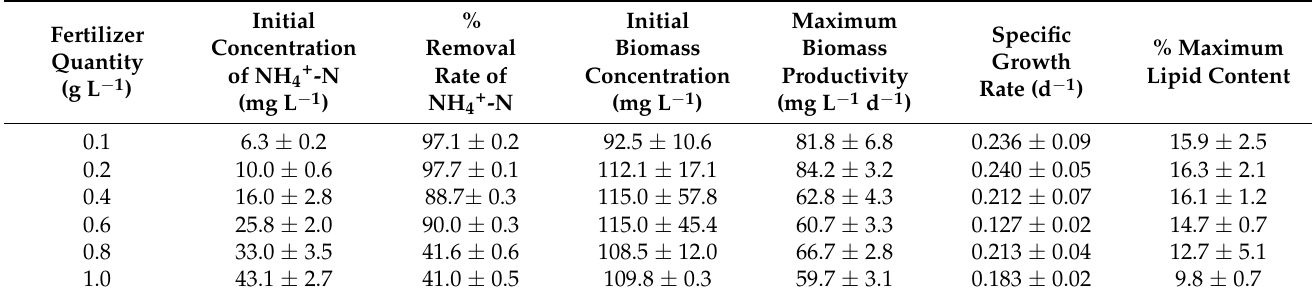
Table 3. Ammonium nitrogen removal rates, biomass productivities, specific growth rates and lipid contents achieved under the different fertilizer